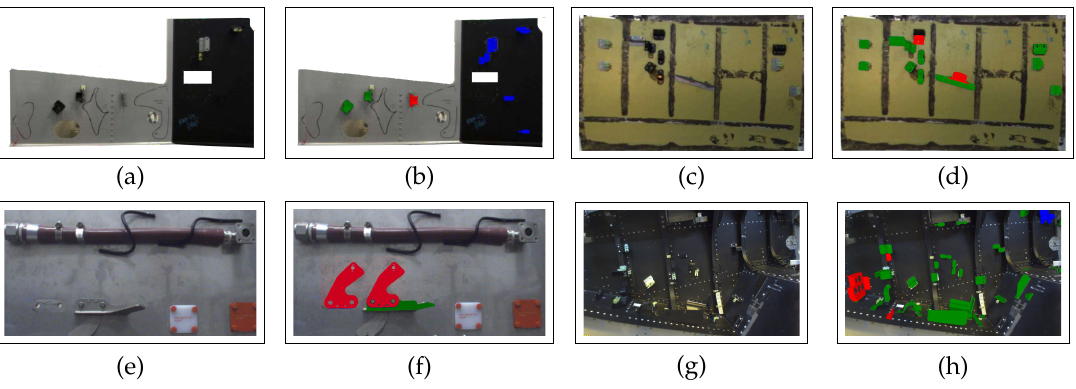
Figure 27. Dataset used to evaluate our algorithms: ( a , c , e , g ) real images and ( b , d , f , h ) corresponding inspection results with OK elements in green and NOK elements in red. Table 7. Performance measures (Section 6.5).